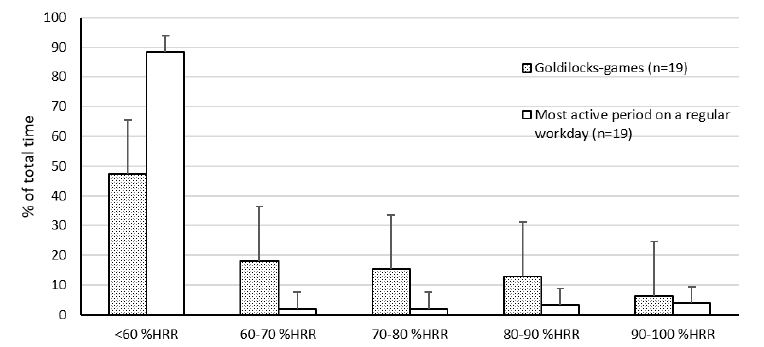
Figure 7. Distribution, in terms of percent time, of percent heart rate reserve during the Goldilocks-games (grey bars) and during the most active period on a regular workday (white bars). Bars show arithmetic group means, with SD between workers illustrated by the error bars. Abbreviation: HRR, heart rate reserve.